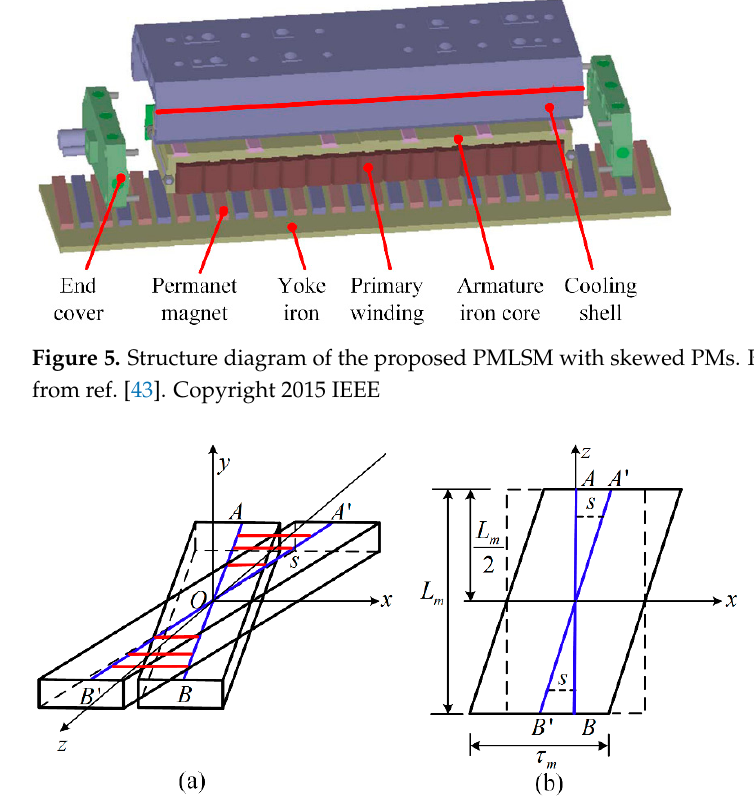
Figure 6. ( a ) Three-dimensional view of the skewed PM; ( b ) view of the skewed PM in the y-direction. Reprinted with permission from ref. [43]. Copyright 2015 IEEE.